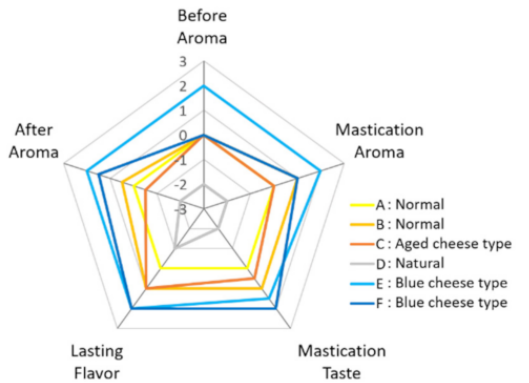
Figure 3. Aroma intensity scores and related sensory scores of the 6 cheese samples in sensory scores (Median).